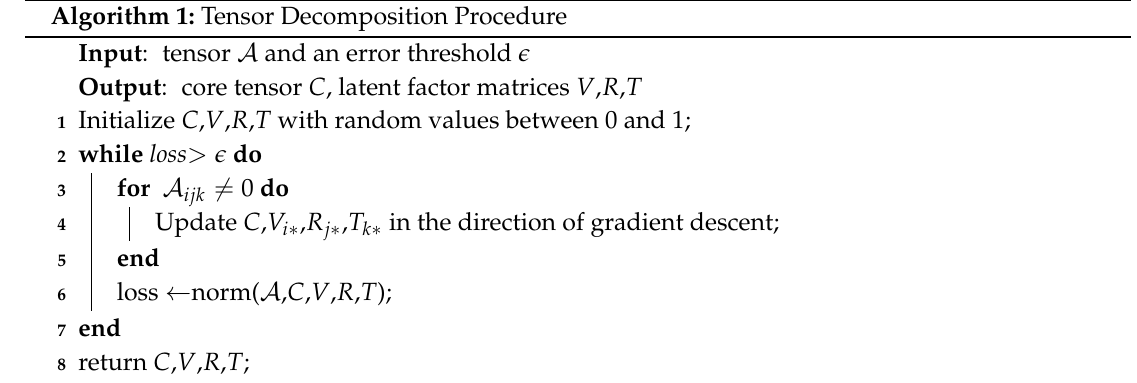
Algorithm 1: Tensor Decomposition